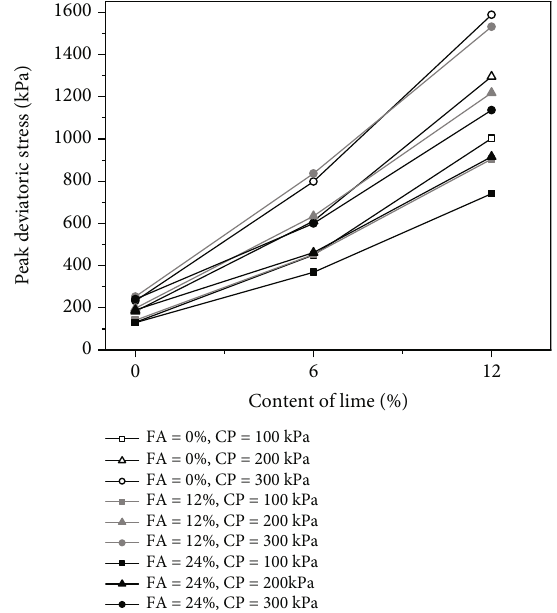
Figure 23: Peak deviatoric stress at di ff erent lime contents ( FT = 0